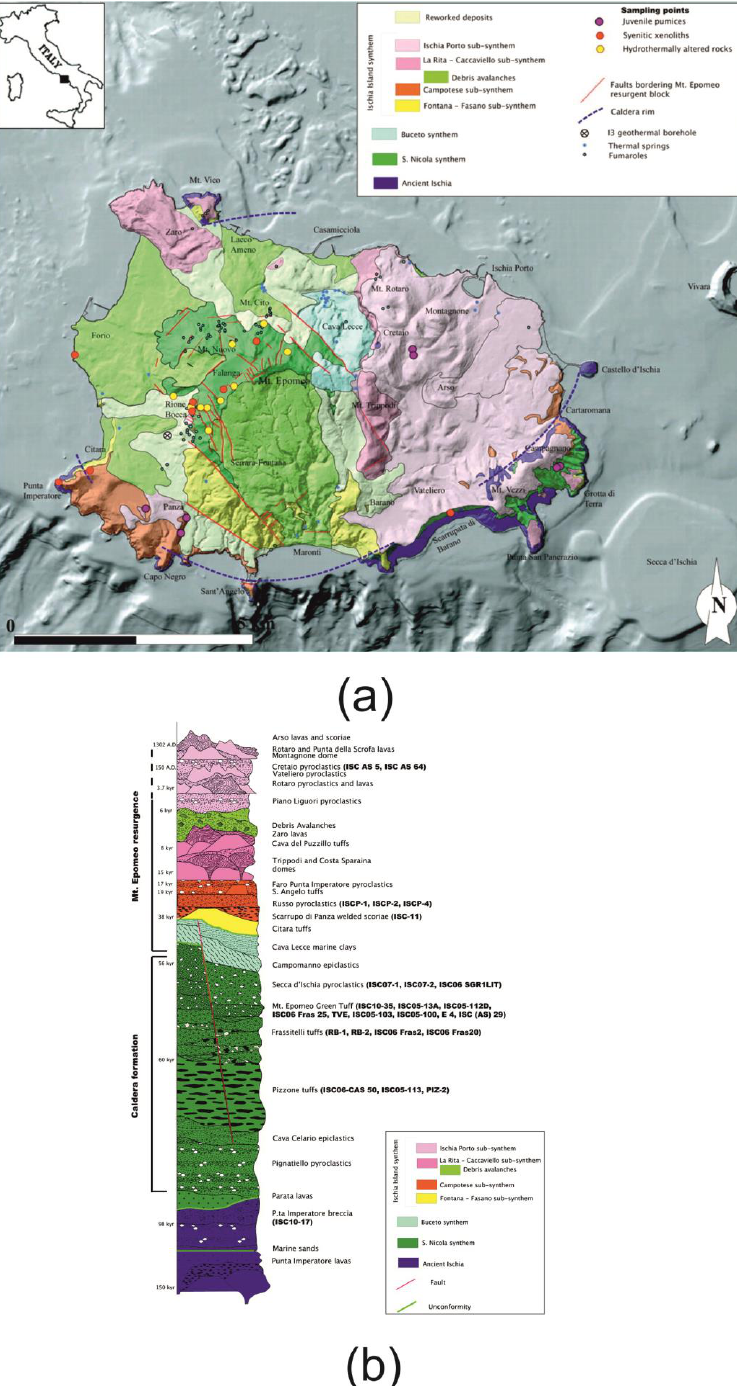
Figure 2. ( a ) Geologic map of Ischia Island; ( b ) composite chrono-stratigraphic sequence of Ischia (modified after